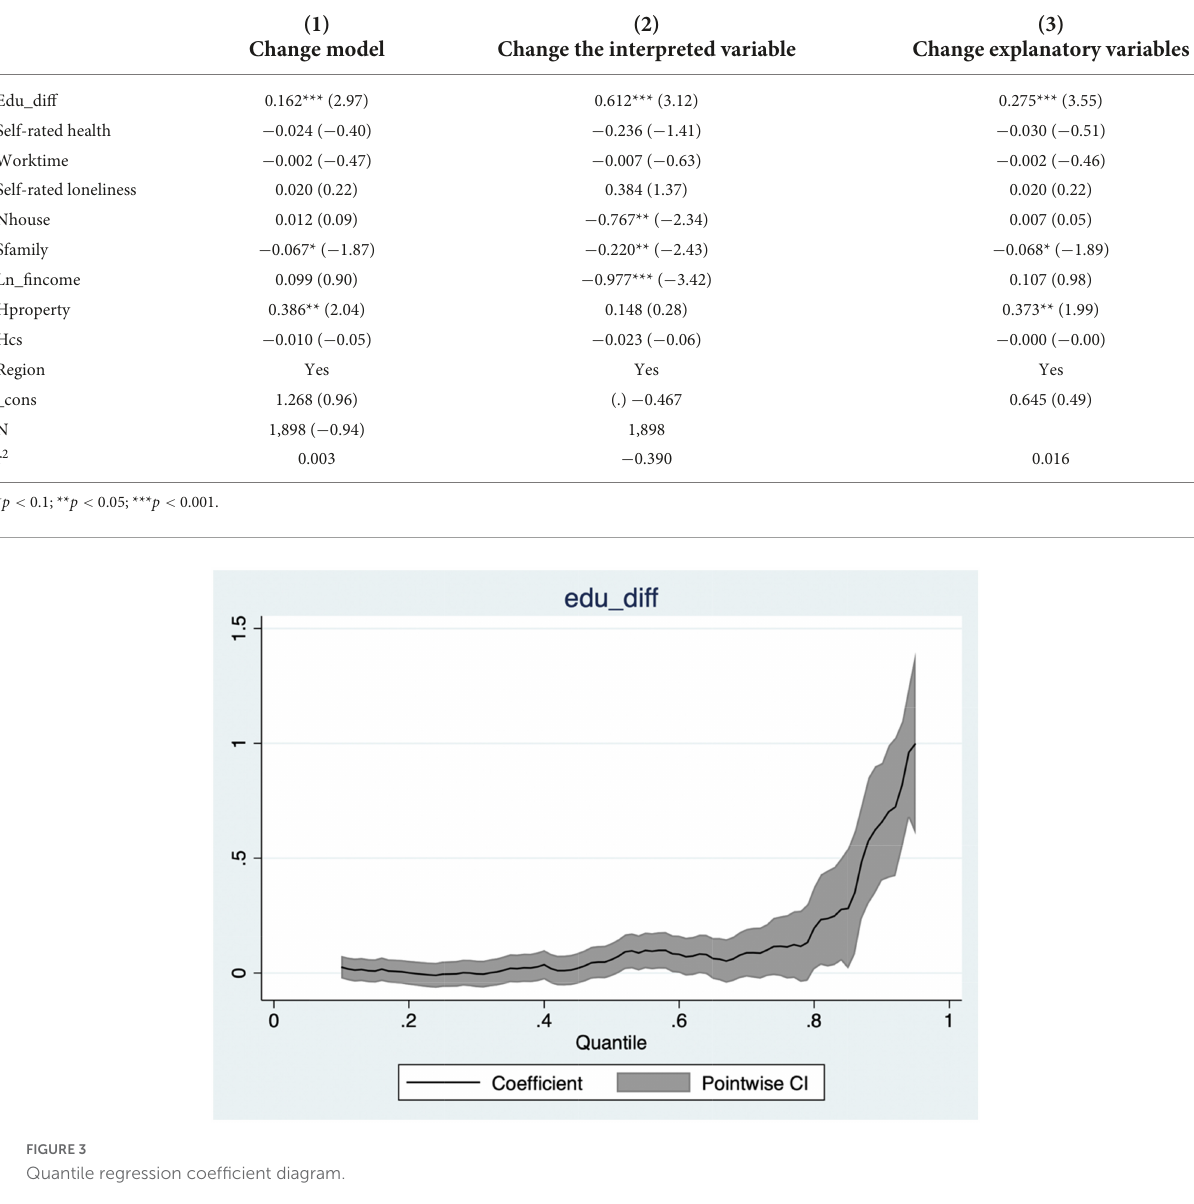
TABLE 5 Robustness test results.